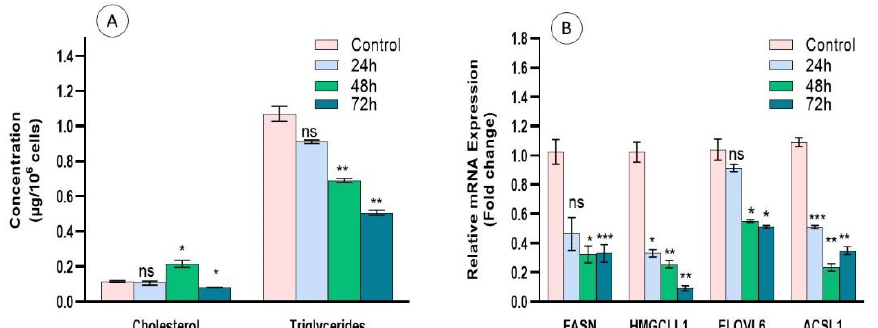
Figure 7. ( A ) Quantification of intracellular cholesterol and triglyceride concentrations in MCF7 cells treated with C. colocynthis silver nanoparticles (Cc-AgNPs) in a time-dependent manner after 24, 48, and 72 h treatment compared with control without any treatment. ( B ) Expression of genes involved in lipid metabolism, FASN, HMGCLL1, ELOV6, and ACSL1, after time-dependent treatment with Cc-AgNPs compared with untreated control cells. (* p < 0.05, ** p < 0.01, *** p < 0.001.)